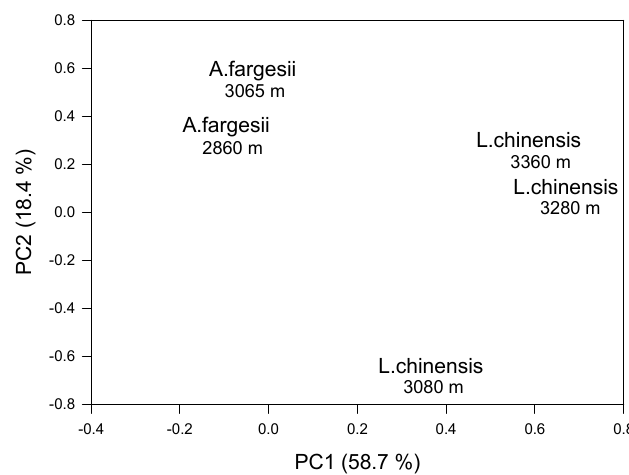
Figure 4. Loadings of the first and second principal components (PC1 and PC2) calculated on the covariance matrix of the five standard tree-ring width chronologies shown in Figure 3a and considering the common 1920–2015 period. Numbers indicate the forest elevations.